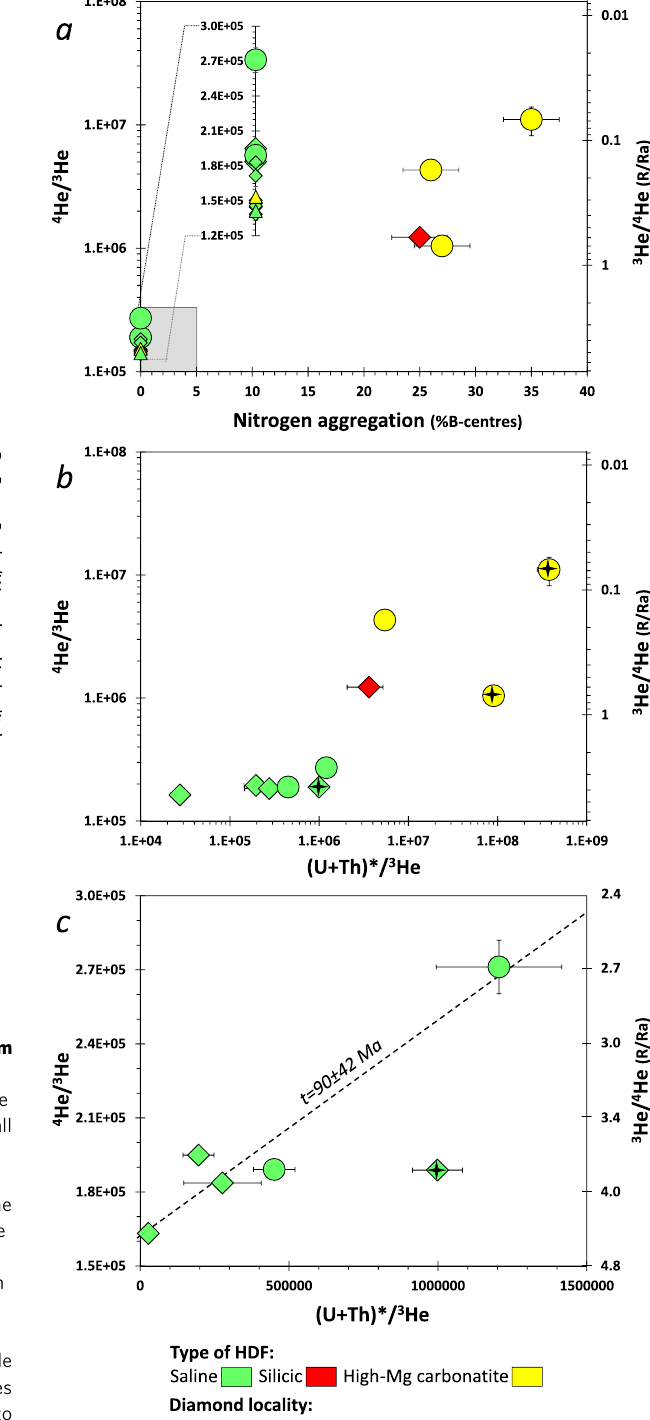
4 He/ 3 He vs. (U + Th) * / 3 He diagram (where (U + Th) * = (1.291 × 238 U + 0.2969 × 232 Th) Ga − 1 and is the 4 He production rate), with the lowest values in the saline HDF-bearing diamonds and higher values in those carrying silicic and carbonatitic fl uids. This rela- tionship, which also correlates with increasing nitrogen aggregation in the host diamonds, re fl ects the ingrowth of radiogenic 4 He with time since diamond formation at depth. Moreover, excluding one